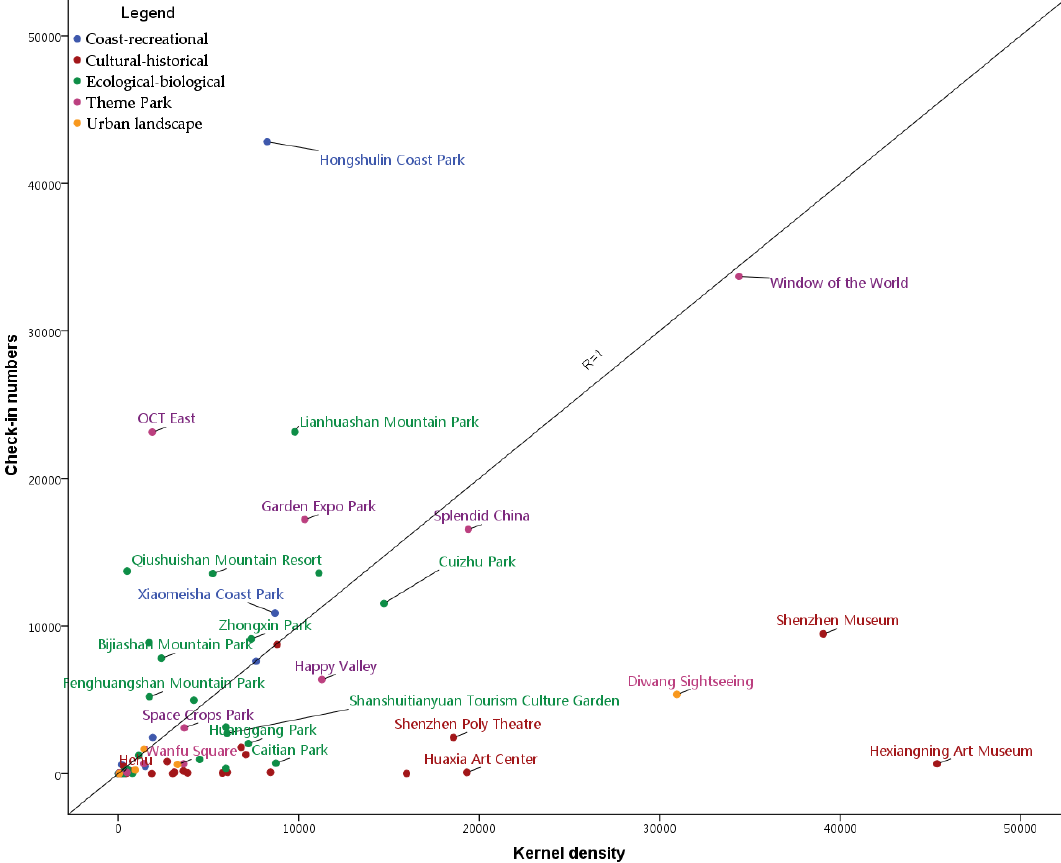
Figure 6. Matrix of check-in numbers and kernel density of 86 tourist attractions.